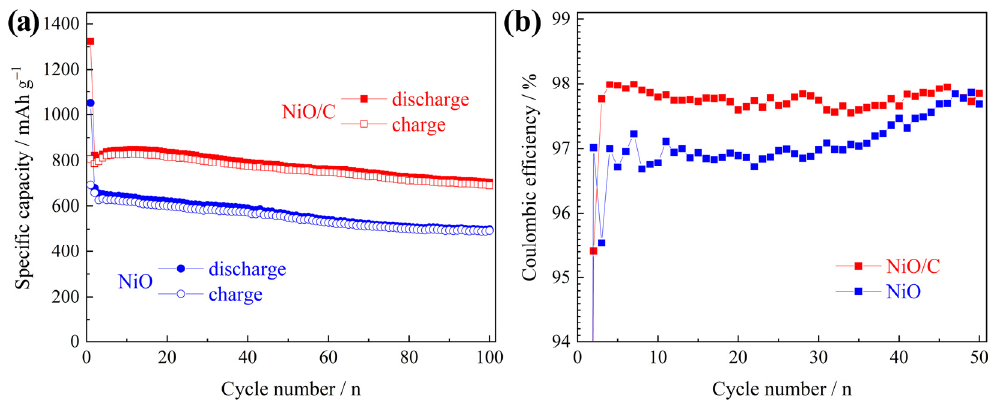
Figure 8. Comparison of ( a ) cycling performance and ( b ) coulombic efficiency between the two electrodes.